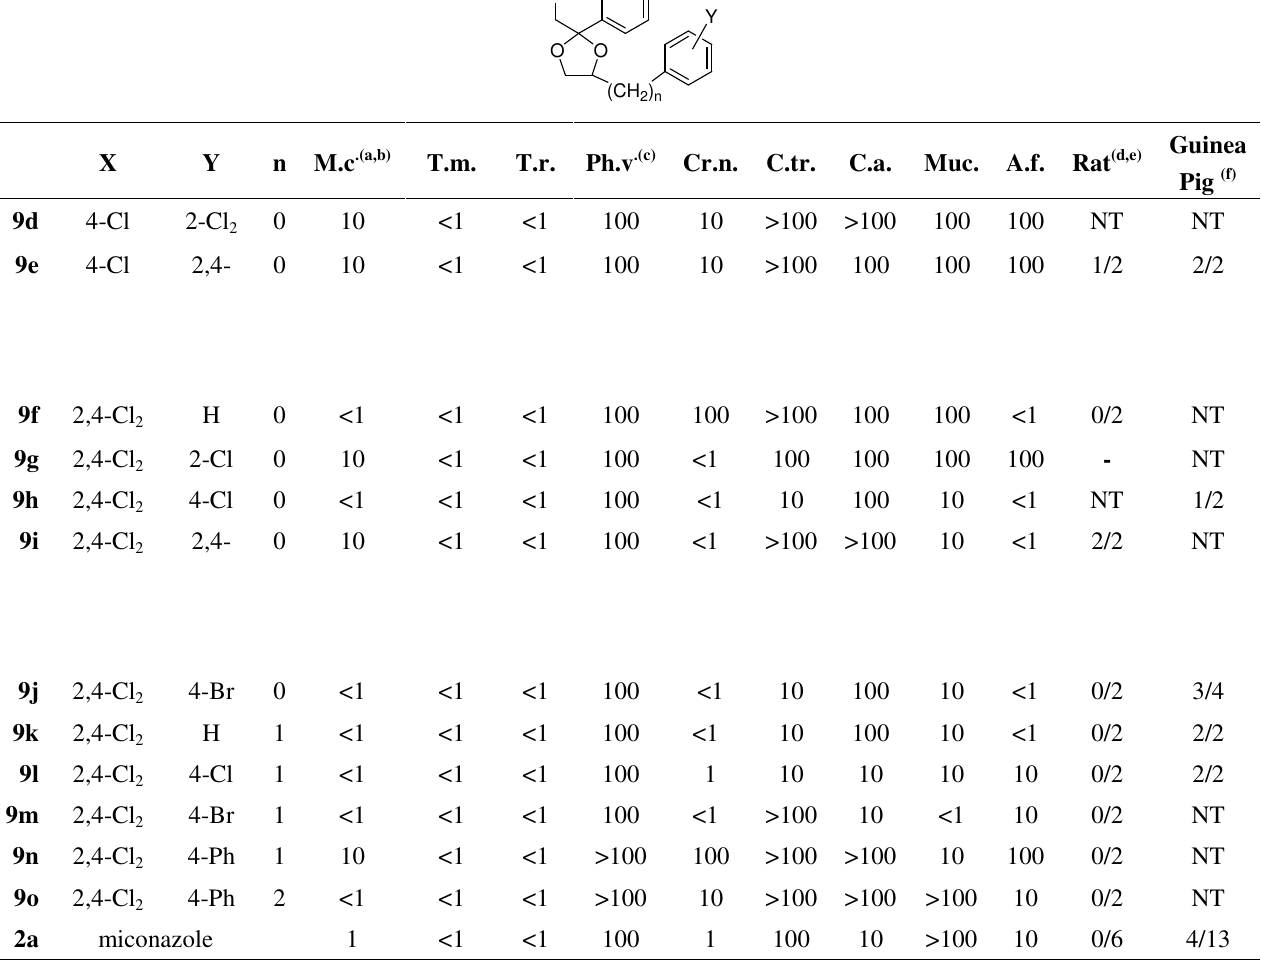
Table 3. In vitro antifungal and antibacterial activities and in vivo antifungal data of miconazole analogues containing a dioxolane scaffold